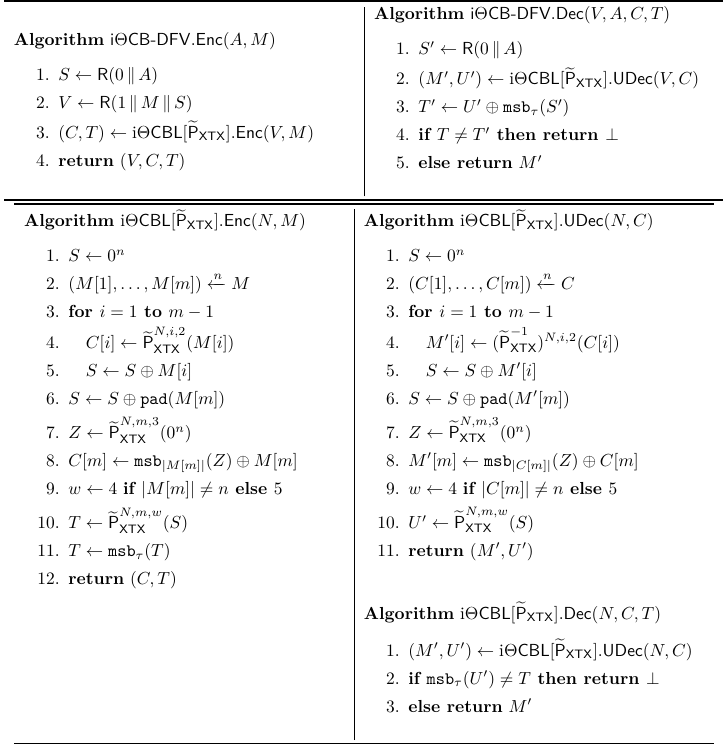
Figure 13: (Top) i Θ CB-DFV using a URF R : { 0 , 1 } ∗ → { 0 , 1 } 2 n and an idealized variant of Θ CBL , iΘ CBL . (Bottom) iΘ CBL . It is based on a TURP e P